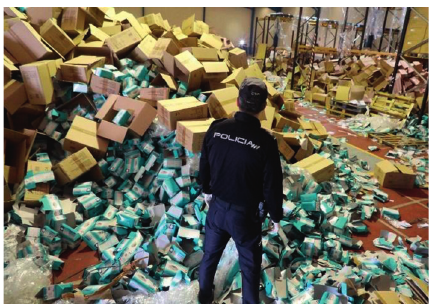
Figure 18: A national police officer surveys a pile of empty boxes left in a huge mask theft in Santiago